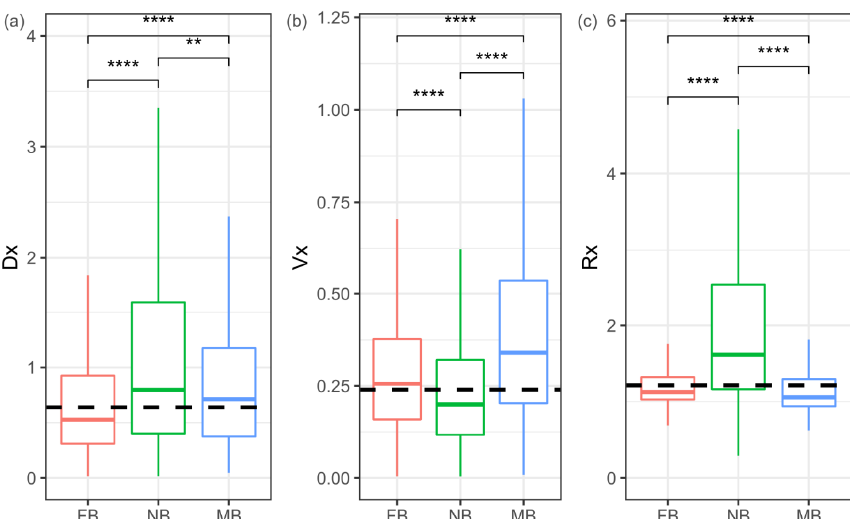
Figure 4. Evolution of gene expression in sex-biased and non-sex-biased genes. Gene expression variations: interspecific (Dx) ( a ), intraspecific (Vx) ( b ), and their ratio (Rx = Dx / Vx) ( c ) in each